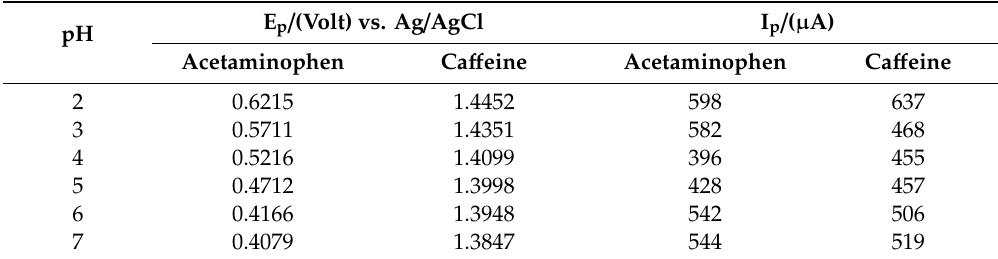
Figure 8. CV ( a ) and DPV ( b ) voltammograms of 1 mM acetaminophen and caffeine in BR pH 2–7, respectively, measured with a working electrode of GCE-M221-Fe 3 O 4 . Table 3. Peak potential (Ep) and peak current (Ip) of acetaminophen and caffeine 1 mM in various Britton Robinson (BR) buffer solutions pH 2–7.